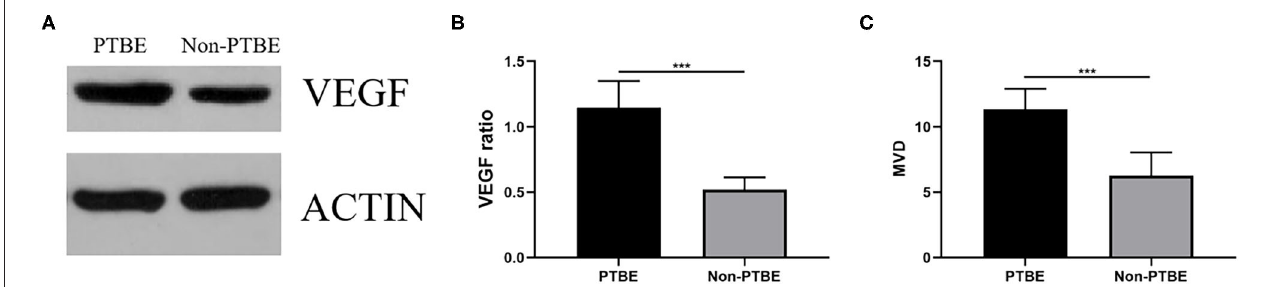
FIGURE 3 | The expression of VEGF and the amount of MVD. (A) The bands of VEGF in the two groups by Western blotting analysis. (B) Expression analysis showed that patients in the PTBE group had significantly higher expression level of VEGF than those of the non-PTBE group. (C) The amount of MVD in the PTBE group was significantly higher than that in the non-PTBE group. *** p < 0.001.